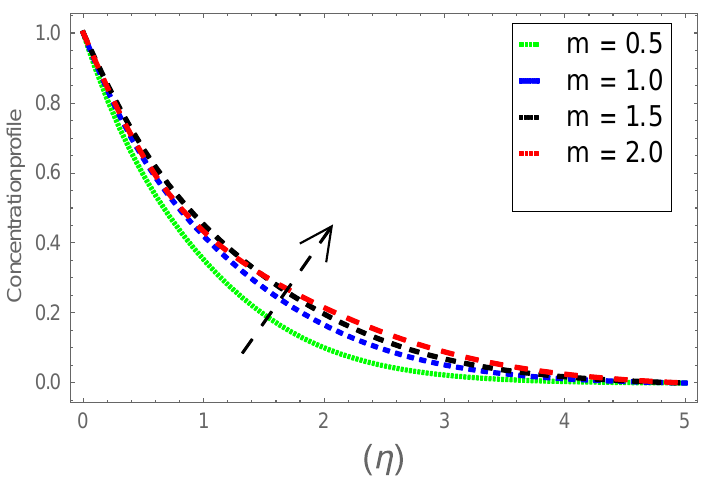
Figure 7. Consequence of ( m ) via θ ( η ) .